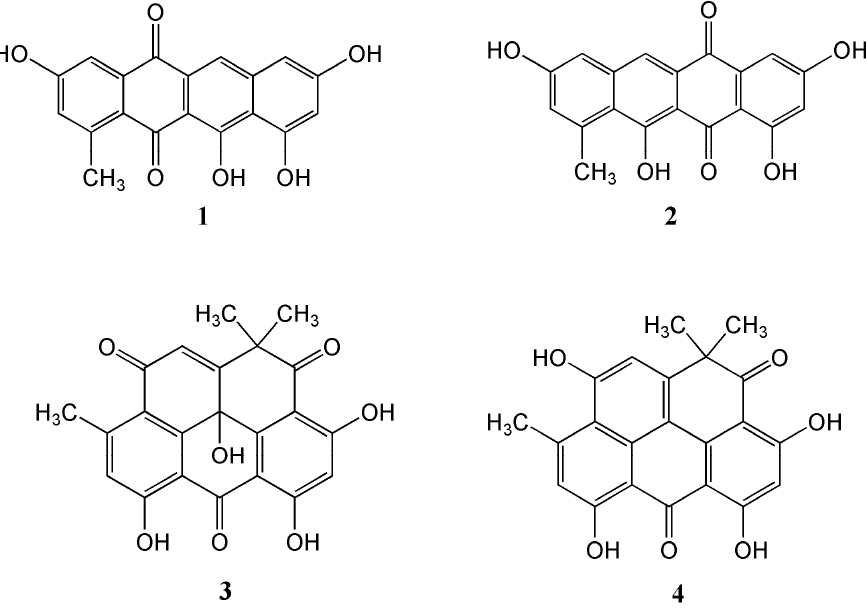
Figure 1. Structures of the isolated compounds 1-4.